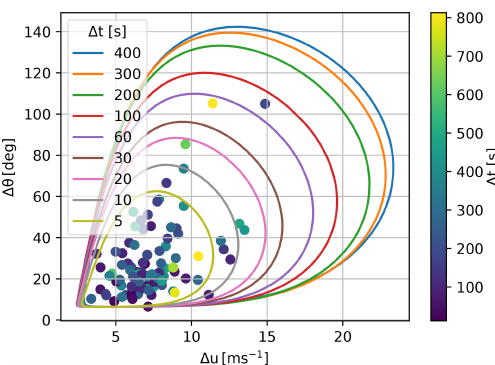
Figure 3. The 50-year return period surface, sliced at different rise times. The color scale shows the rise time for the 92 coherent gust